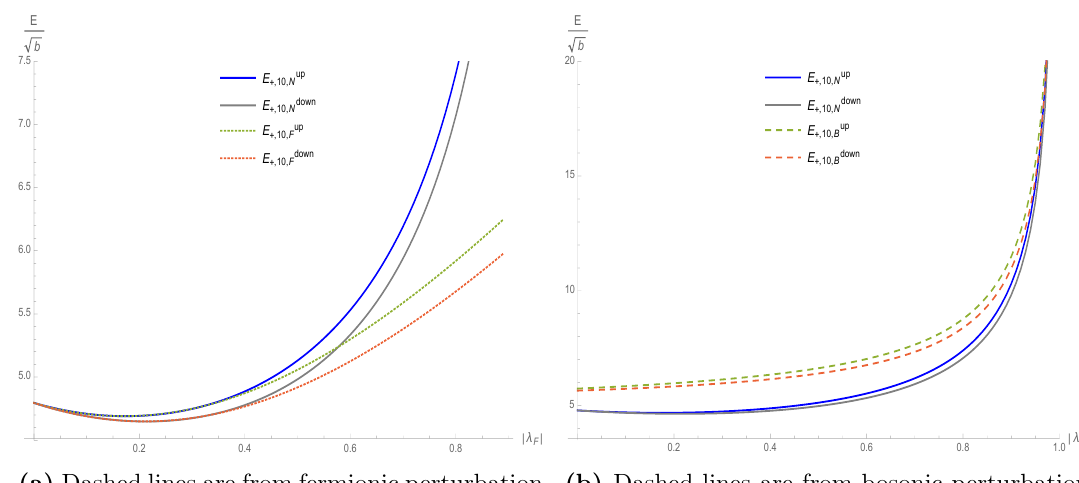
(a) Dashed lines are from fermionic perturbation theory. Solid lines are from numerical analysis. Figure 3. Upper and lower critical chemical potentials for the M = 10 positive energy band function of (cid:21) F for sgn(b (cid:21) F ) = (cid:0) 1, at (cid:12)xed m cri